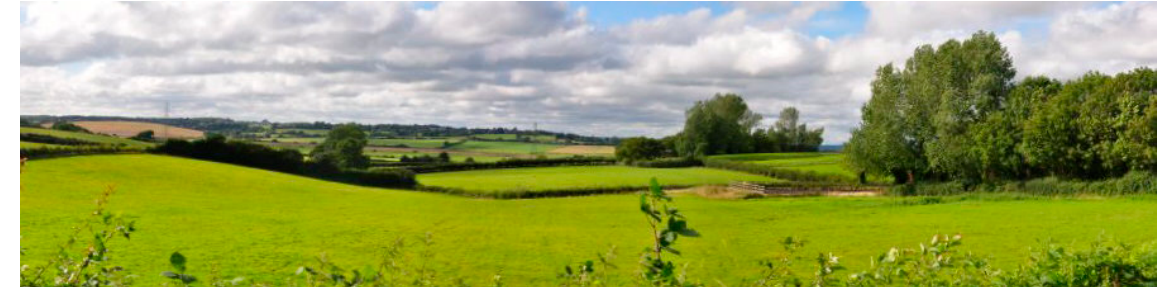
Figure 3. East Sussex landscape, near Battle (1066, Norman Conquest).